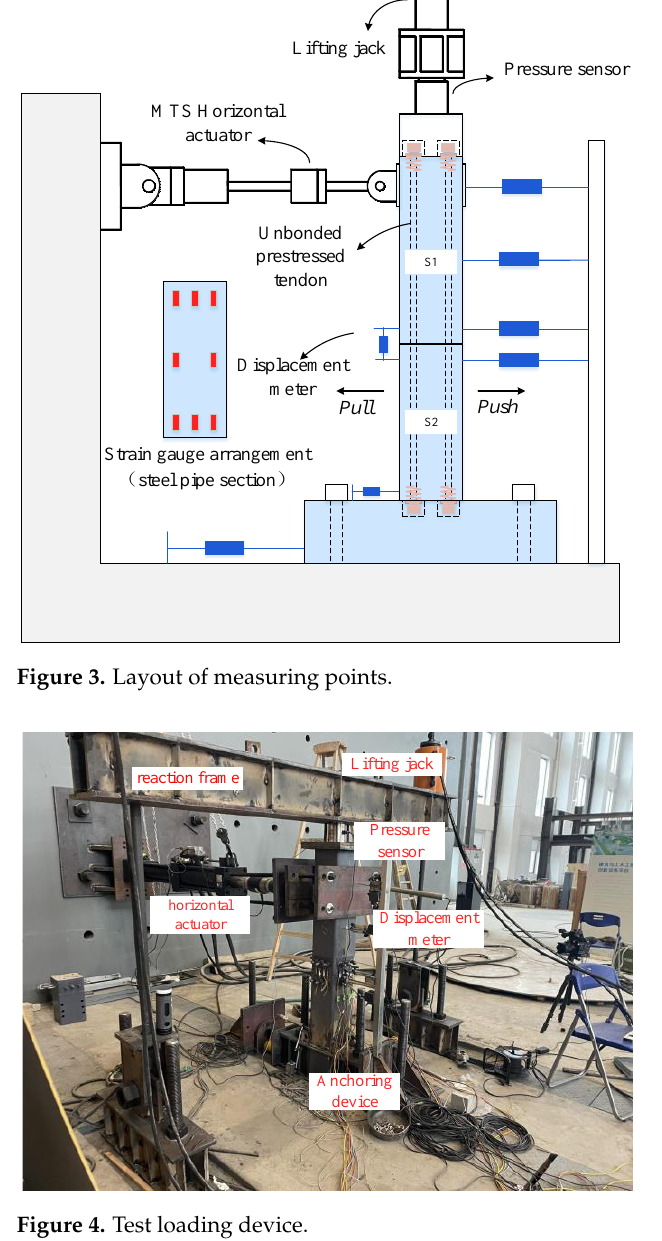
Figure 2. Structure of CFST pier test piece assembled in segments.